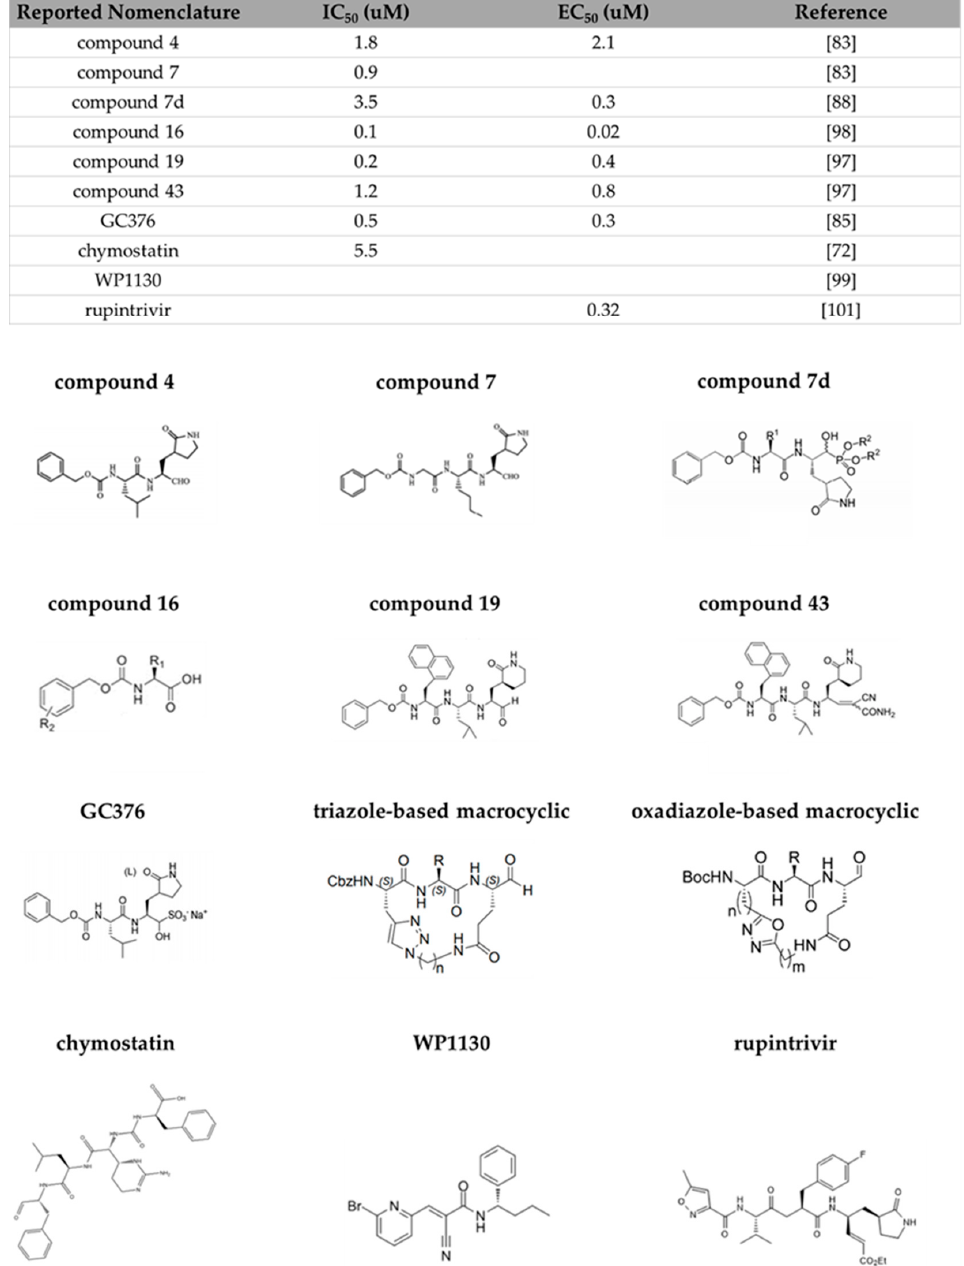
Figure 8. Inhibition potency of representative Norwalk protease inhibitors. The chemical structures and inhibition potencies of representative linear aldehyde peptidomimetic inhibitors (compound 4 and 7 ), linear hydroxyphosphonate peptidomimetic inhibitor (compound 7 d), linear cyclohexylalanine peptidomimetic inhibitor (compound 16 ), linear lactam peptidomimetic inhibitor (compound 19 ), linear cyanoacrylamide peptidomimetic inhibitor (compound 43 ), prodrug GC376, triazole-based and oxadiazole-based macrocyclic inhibitors, and commercially available inhibitors (chymostatin, WP1130, rupintrivir).